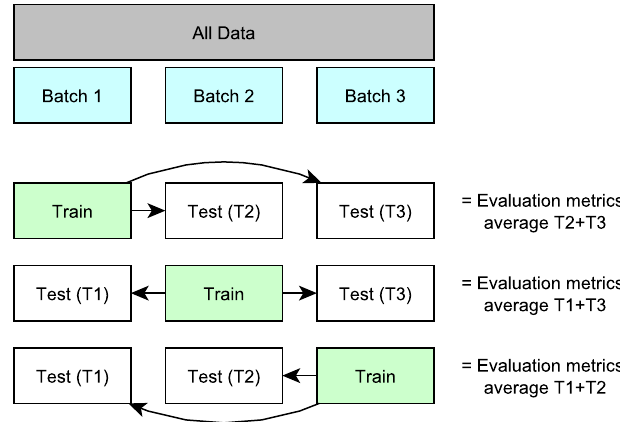
Figure 4. Example of k-fold cross-testing applied with k =